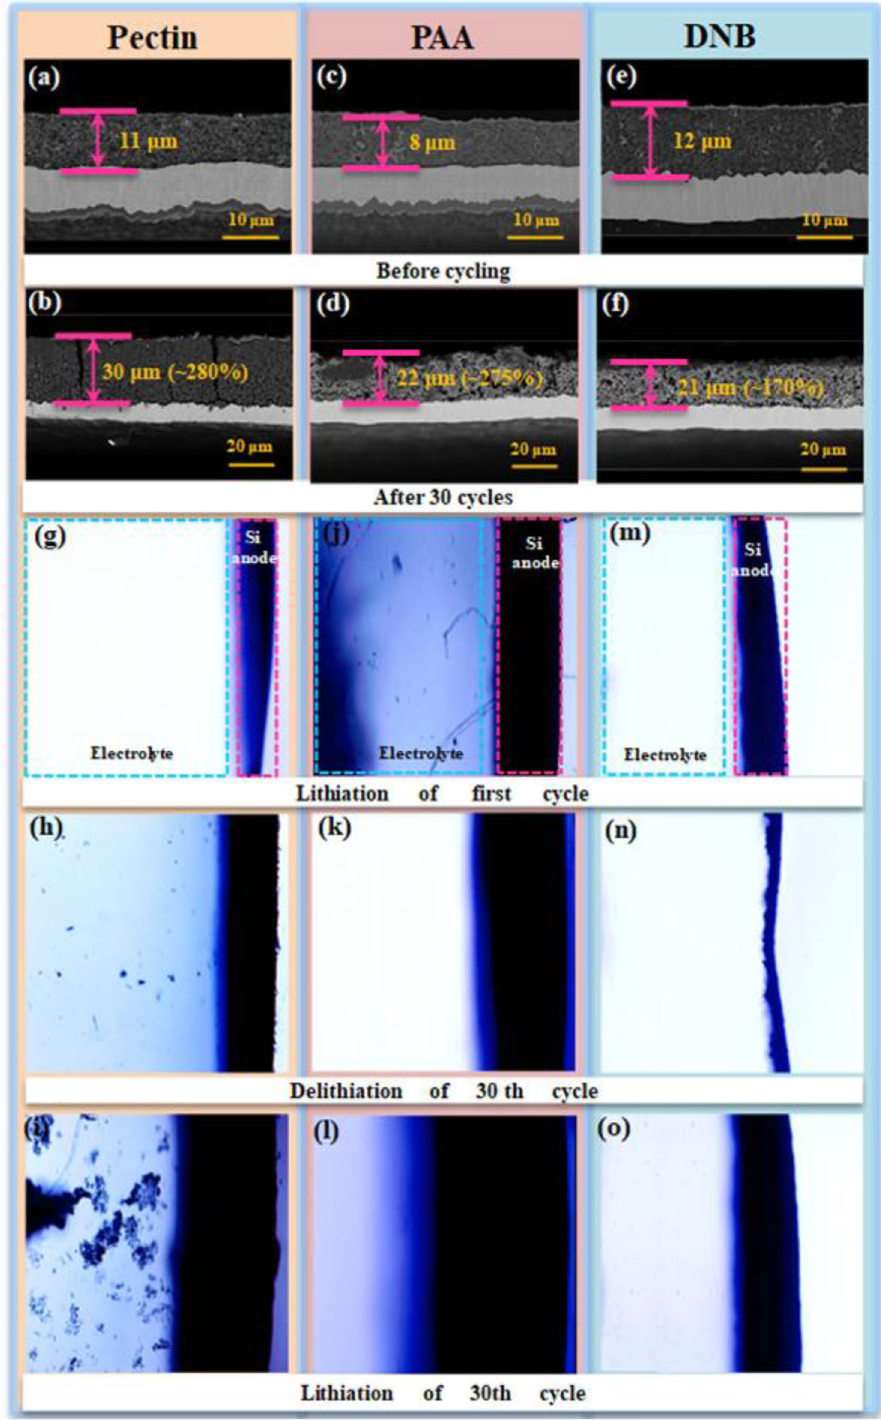
Fig. 3 Cross-sectional SEM images of Si electrodes before ( a – c ) and after 30 cycles ( d – f ) with pectin, PAA, and DNB, respectively. In situ optical microscopy images of volume change of Si electrodes upon lithiation of first cycle and lithiation/delithiation of 30th cycle with ( g – i ) pec- tin binder, ( j – l ) PAA binder, and ( m – o ) DNB in assembled model cell